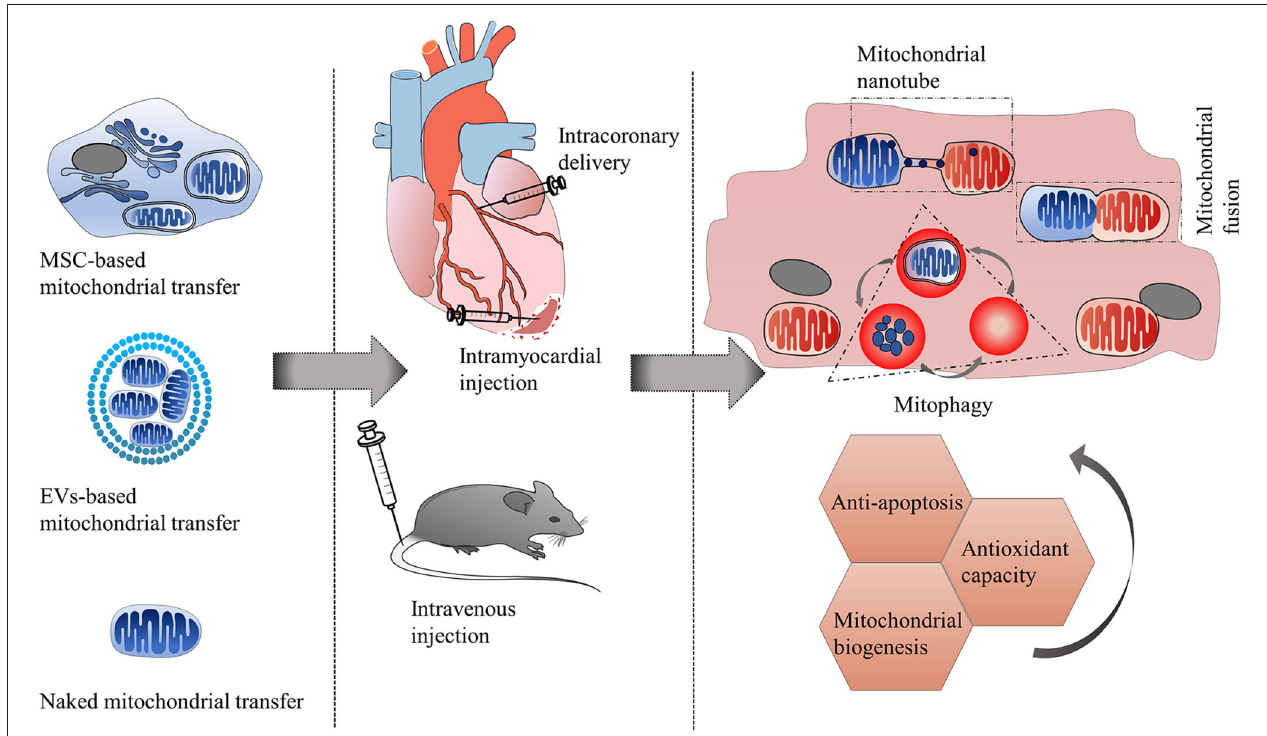
FIGURE 3 | Therapeutic strategies of mitochondrial transfer for cardiovascular diseases. The most common methods of mitochondrial transplantation used for the treatment of cardiovascular diseases (such as ischemic cardiomyopathy, anthracycline-induced cardiomyopathy) are cell-mediated therapy and cell-free therapy (including naked mitochondria transplantation and EV-based transplantation). Routes of administration can be intramyocardial injection, intracoronary delivery, and intravenous injection. After approaching the recipient cells, exogenous mitochondria can integrate with recipient mitochondria through mitochondrial fusion and fission machinery, or be trapped by lysosomes and be autophagy degraded. Some donor mitochondria might only communicate with recipient mitochondria via mitochondrial nanotunnels, without undergoing mitochondrial fusion. The transfer of healthy mitochondria toward injured cells has multiple protective mechanisms including improvement of mitochondrial biogenesis, enhancement of antioxidant capacity and reduction of